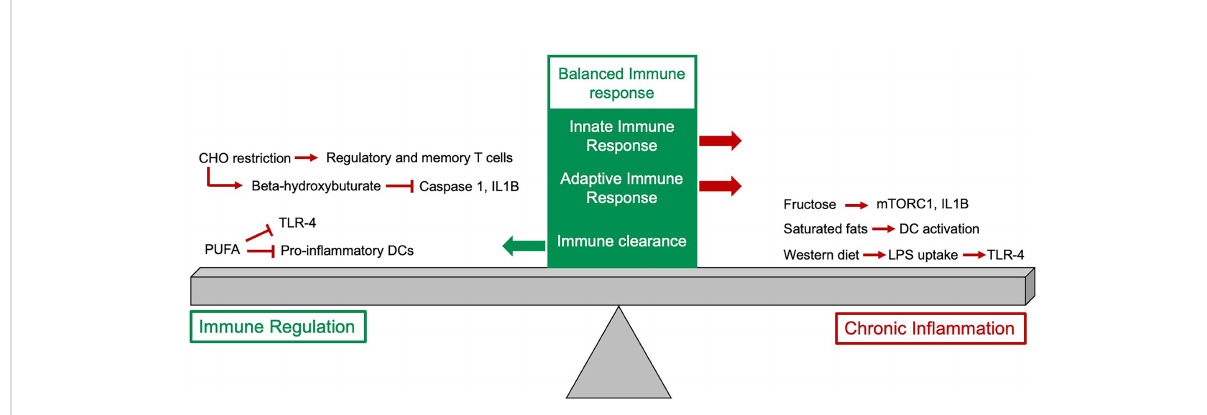
FIGURE 1 The impact of diet on the immune response. The balanced immune response is dependent on expansion of innate and adaptive immune cells as well as an appropriate downregulation of the response. Some dietary components, particularly fructose, saturated fats and the typical western diet have pro-in fl ammatory effects and if these persist this can drive chronic in fl ammation. Other dietary changes, such as reduction in carbohydrate (CHO) intake and increased intake of polyunsaturated fatty acids can help to downregulate the immune